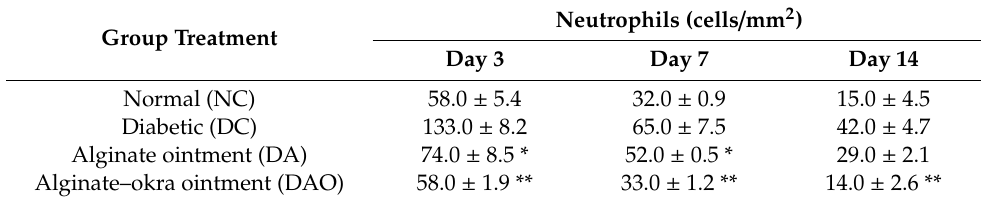
Table 4. Counts considering the mean and standard deviation of neutrophils.